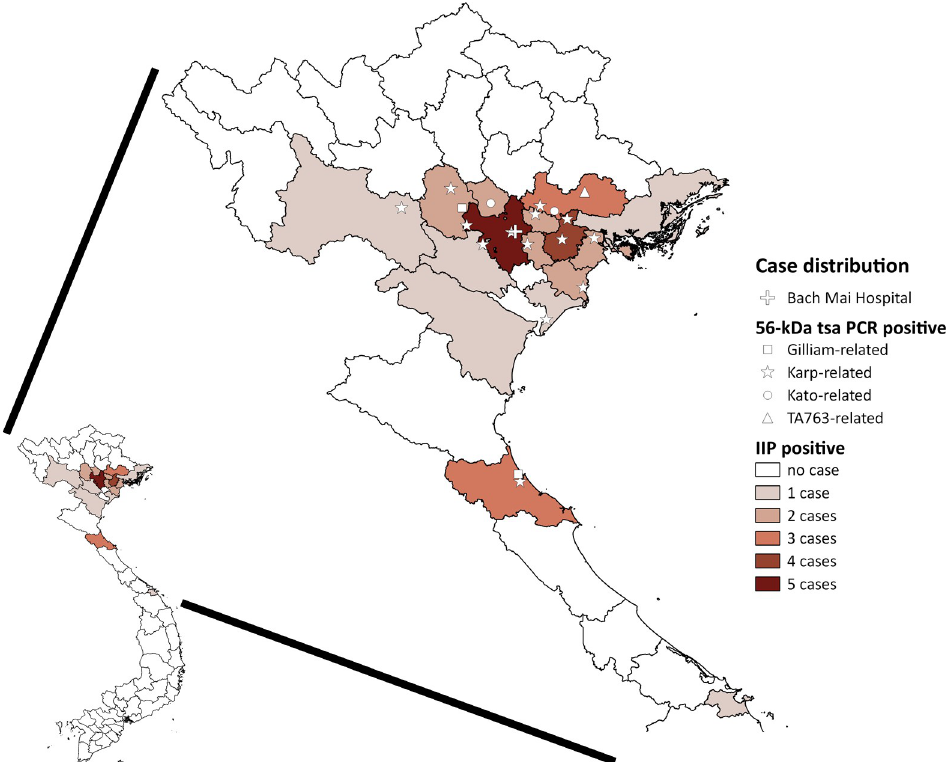
Fig 3. Geographical distribution of patients’ home addresses with positive results by 56-kDa tsa PCR and/or IgM ELISA, and the location of Bach Mai Hospital. The numbers of IgM ELISA-positive cases were counted by province. The map image was created by QGIS 2.18.11 software (Open Source Geospatial Foundation Project. https://www.qgis. org) using cartographic data files extracted from the GADM database (www.gadm.org), version 2.5 (July 2015).